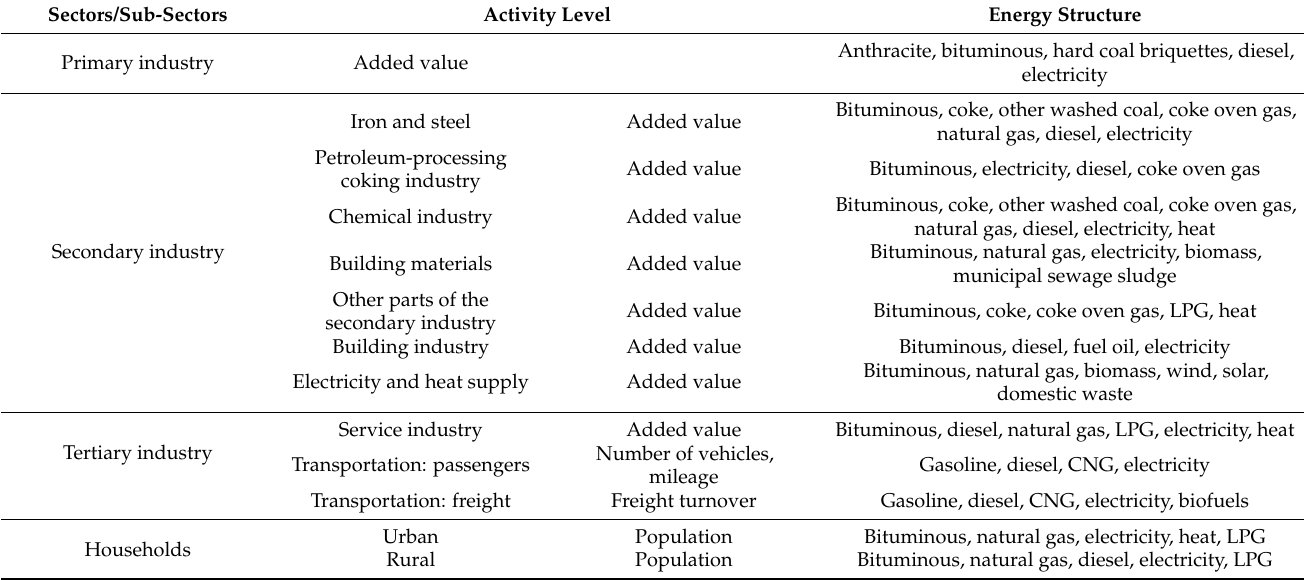
Table 1. The structure of